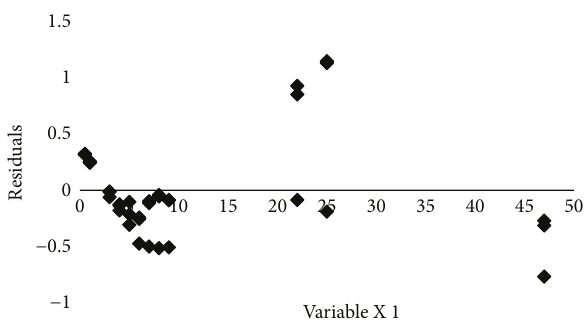
Figure 15: First-order residuals